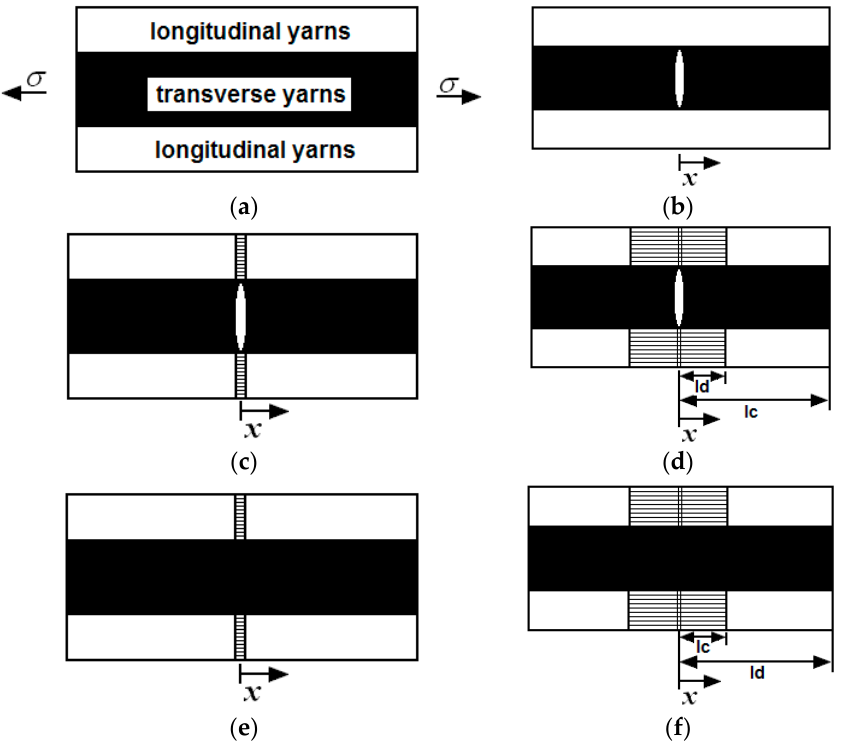
Figure 1. The undamaged state and five damaged modes of 2D woven CMCs: ( a ) undamaged composite; ( b ) mode 1: transverse cracking; ( c ) mode 2: transverse cracking and matrix cracking with perfect fiber/matrix bonding; ( d ) mode 3: transverse cracking and matrix cracking with fiber/matrix interface debonding; ( e ) mode 4: matrix cracking with perfect fiber/matrix bonding; and ( f ) mode 5: matrix cracking with fiber/matrix debonding.